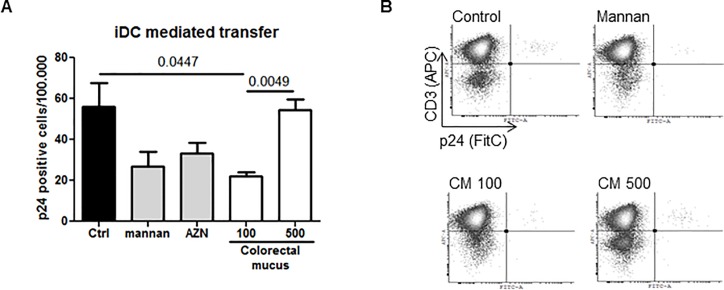
CM inhibits HIV-1 trans-infection by iDCs.(A) iDCs were pre-incubated with 100 fold diluted CM, 20μg/ml AZN-D1 (DC-SIGN blocking antibody), 50μg/ml mannan or medium (control) before addition of LAI. Using flow cytometry viral outgrowth in iDC – CD4 T-lymphocyte co-cultures was measured by intracellular staining for p24. Depicted is the number of p24+ cells per 1x105 CD3+ T cells. (B) Shown are representative dot plots of the data depict in (A). Data points were performed in triplicate.